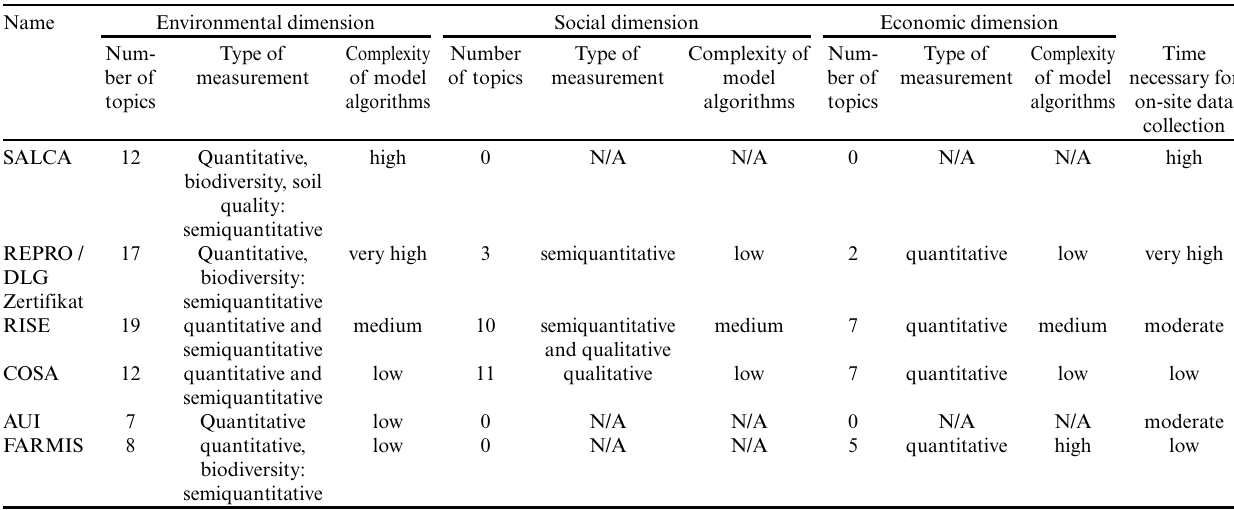
Table 3 . Comparison of the precision of the six selected sustainability impact assessment